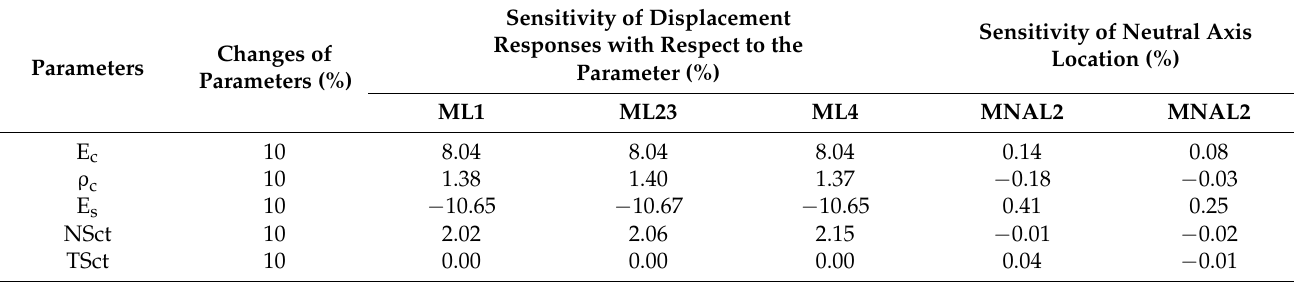
Table 7. Sensitivity analysis results of the candidate model